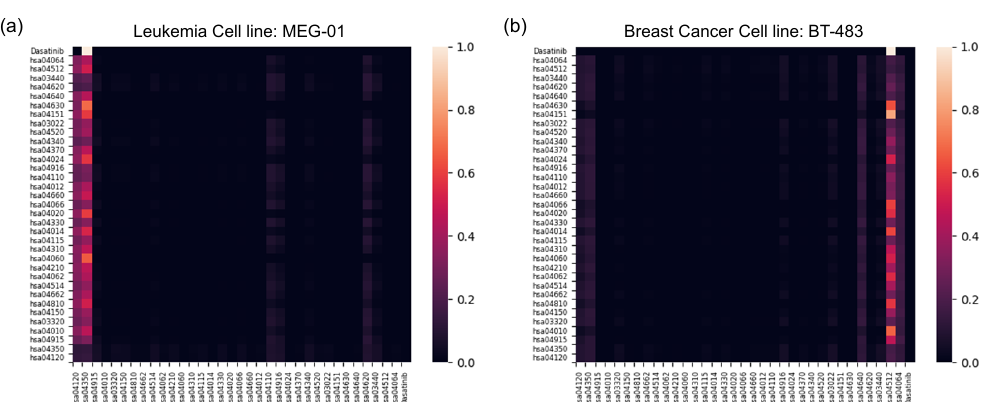
Figure 4. Visualization of all-pairwise self-attention scores from the transformer. ( a ) Dasatinib and leukemia cell line MEG-01 pair. ( b ) Dasatinib and breast cancer cell line BT-483. The figures show the y-axis as the query of the transformer and the x-axis as the key. On each axis, there is a drug and 34 pathways which start with “hsa”, indicating KEGG pathway